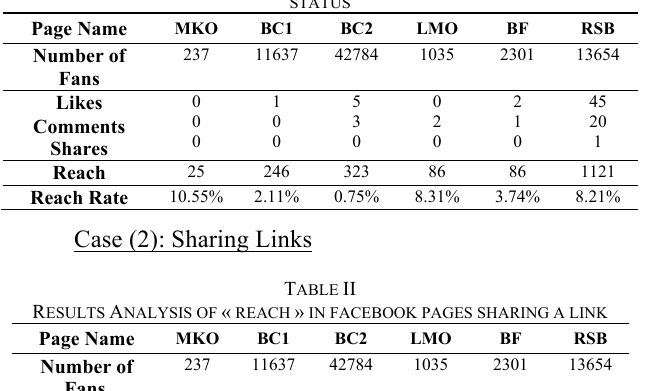
Figure. 5. Result of the question: If you have 1000 fans, how much of "reach" is satisfying for you?